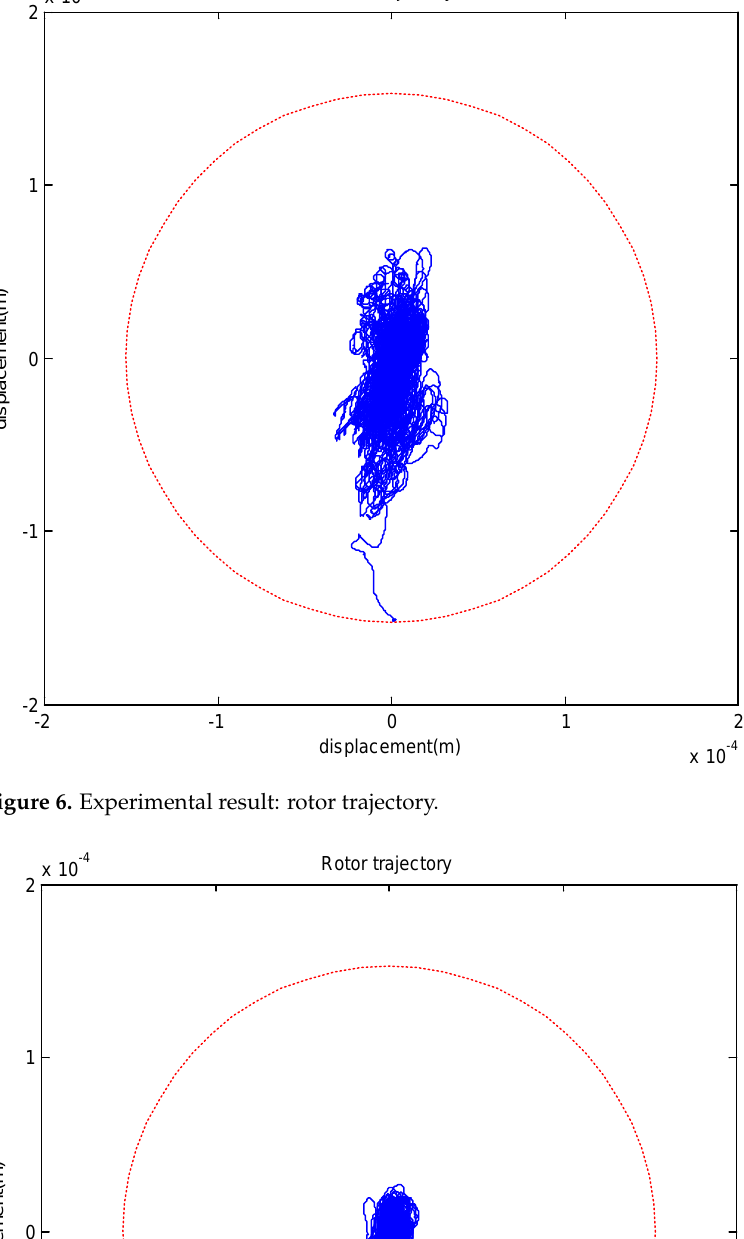
Figure 7. Steady-state rotor trajectory.